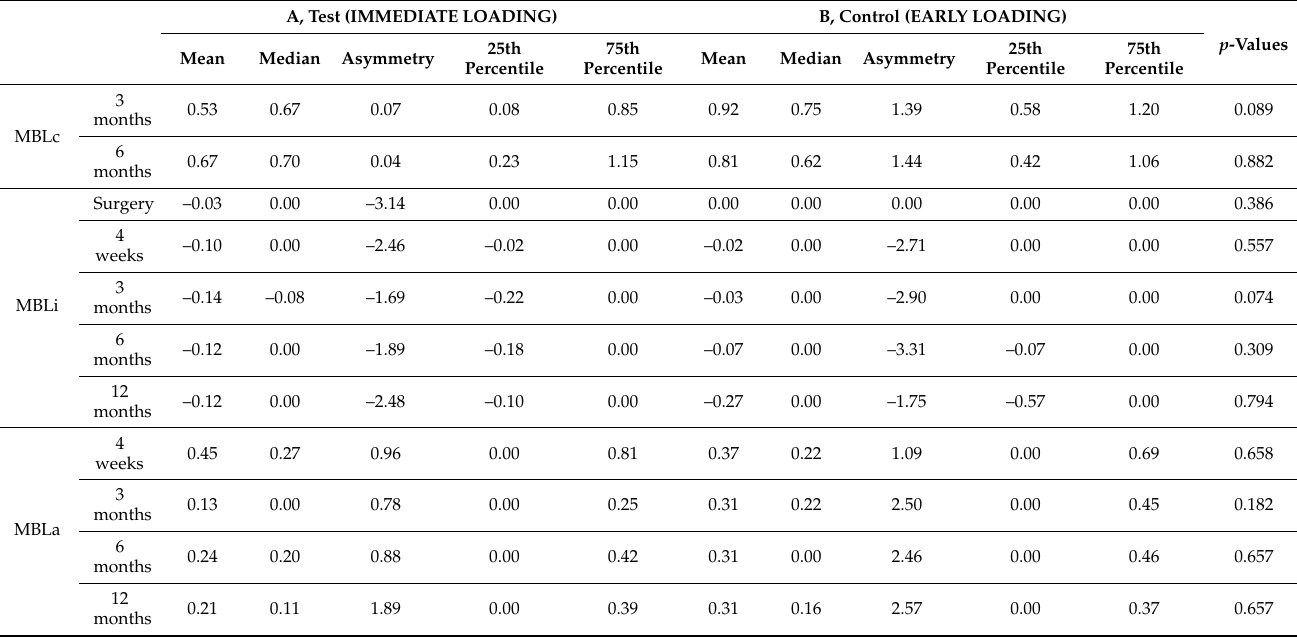
Table 4. Mean, Median & Percentile of the radiographic variables. * p > 0.05. Marginal bone level at the crest (MBLc). Marginal bone level at the implant (MBLi). Marginal bone level at the abutment